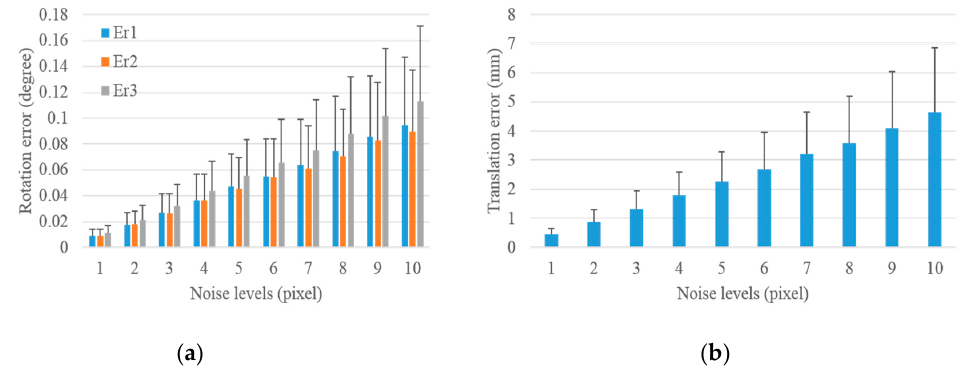
Figure 6. Rotation and translation errors for the extrinsic calibration of camera with respect to the control field under increasing image noise levels. ( a ) Rotation error and ( b ) translation error.